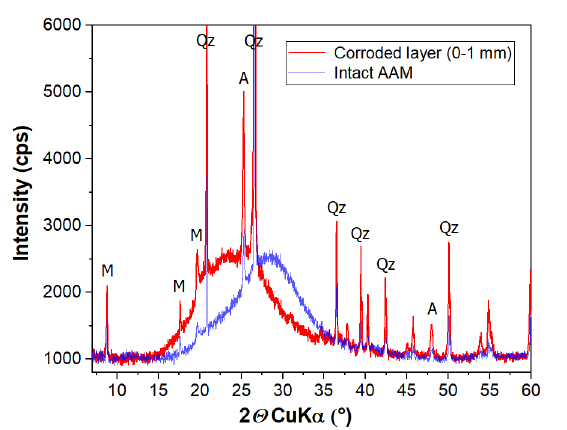
Figure 2. XRD patterns of an intact metakaolin ‐ based AAM and the fully corroded layer of the AAM after exposure to acetic acid. A shift of the major hump in the pattern from ~29° to ~22°C indicates the formation of an Al ‐ poor silica phase. Major peaks of crystalline impurities are labelled: M, muscovite/illite; A, anatase; Qz, quartz. (Data from